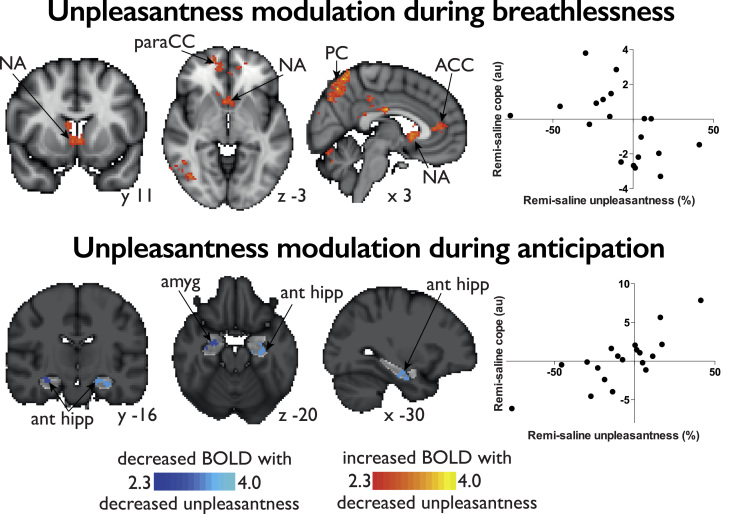
BOLD activity corresponding with remifentanil-induced decreases in unpleasantness scores across subjects. Top: Increases in BOLD activity with remifentanil that negatively correlate with decreases in breathlessness unpleasantness, with a graphical depiction of the contrast of parameter estimate (COPE) from the significant activity in the rostral ACC plotted against the decrease in unpleasantness scores. Bottom: Decreases in BOLD activity with remifentanil that correlate with decreases in unpleasantness during anticipation of strong loading in the hippocampus and amygdala, with a graphical depiction of the contrast of parameter estimate (COPE) from the combined significant activity plotted against the decrease in unpleasantness scores. The image consists of a color-rendered statistical map superimposed on a standard (MNI) brain. The bright gray region delineates the region of interest analysed. Abbreviations: ACC, anterior cingulate cortex; NA, nucleus accumbens; paraCC, paracingulate cortex; prefrontal cortex; PC, precuneus; amyg, amygdala; ant hipp, anterior hippocampus.